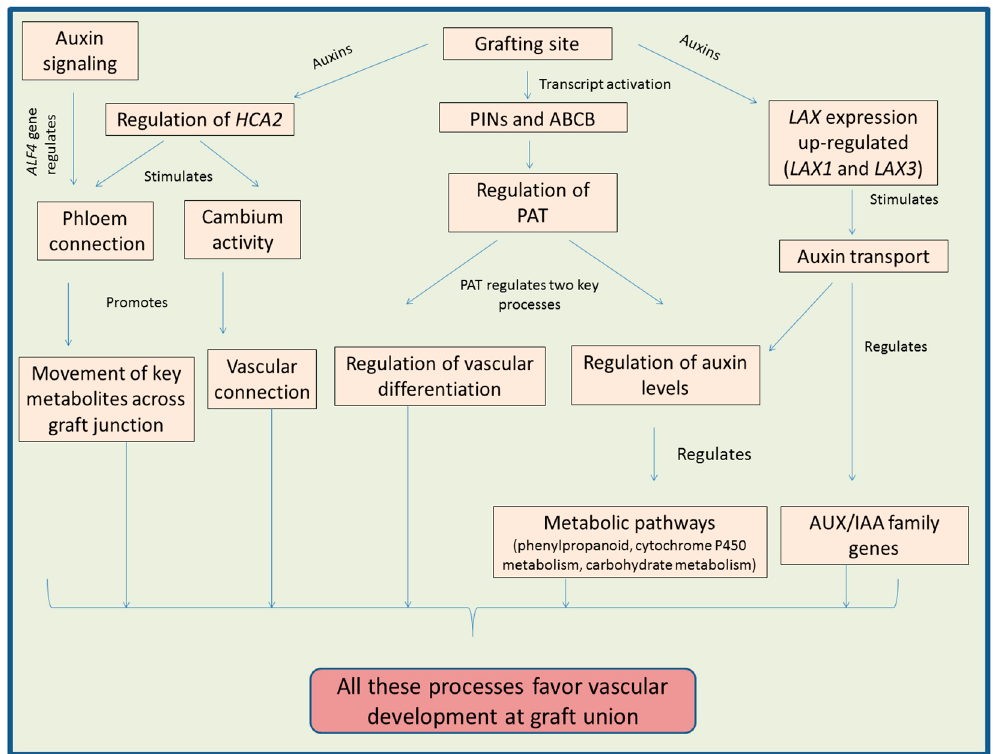
Figure 1. Diagram explaining how auxins regulate the process of plant grafting. It is a conclusion diagram, based on the various studies mentioned in the section related to auxins. PIN-FORMED auxin transport proteins (PINs); ATP-binding cassette subfamily B (ABCB); polar auxin transport (PAT); cytokinin (CK); gibberellins (GA); graft union (GU); LIKE AUXIN RESISTANT1-3 (LAX); HIGH CAMBIAL ACTIVITY2 (HCA2); ABERRANT LATERAL ROOT FORMATION 4 (ALF4).